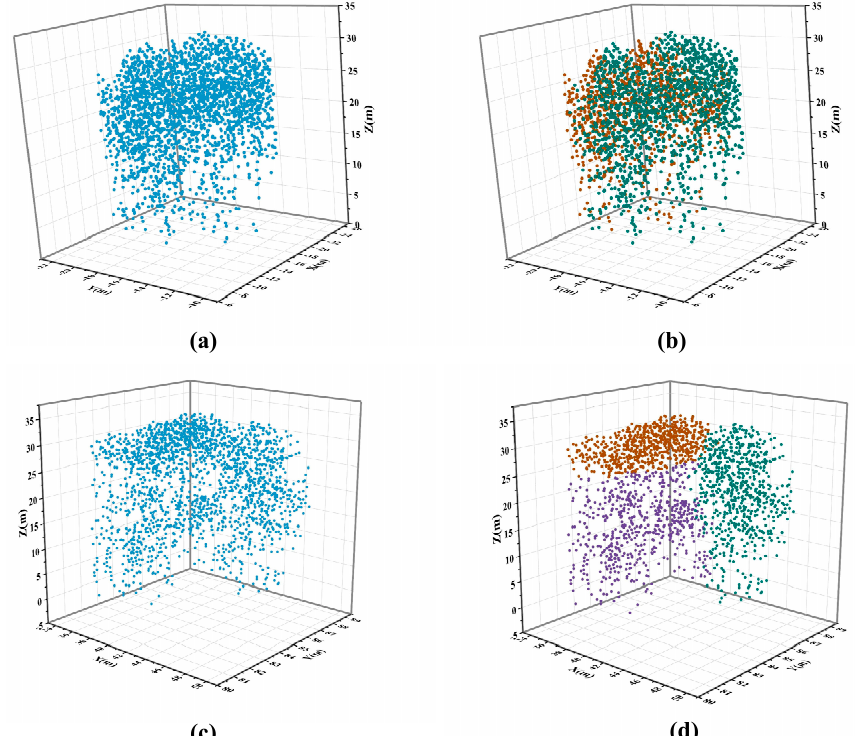
Figure 14. Failure sample example. ( a , b ) Failure example of Case (ii): An approximate center is detected at the junction of two subsamples due to higher density at the junction of two canopies, resulting in failure of optimal segmentation; ( c , d ) Failure example of Case (iii): The approximate centers of the three samples are correctly detected, but the point cloud density distribution of the two subsamples on the left is too dense at the top and too scattered at the bottom, causing the GMM clustering to split them into two homogeneous groups at the top and bottom.